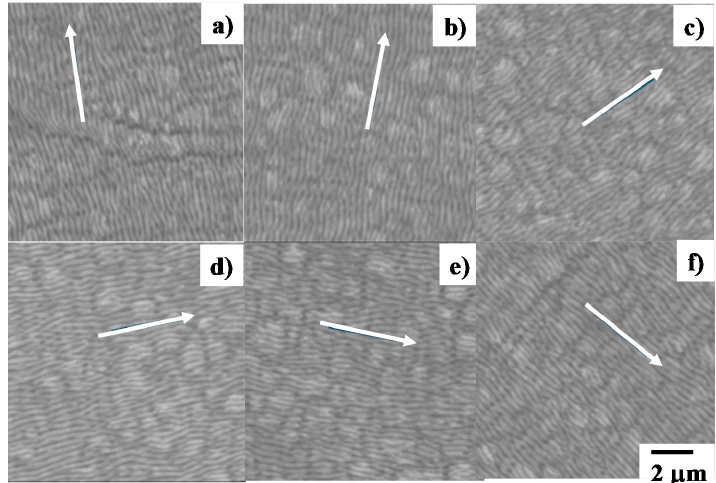
Figure 5. Allocation of nanotextures with different orientations into six segments (#1–#6) in the M6 micropattern.